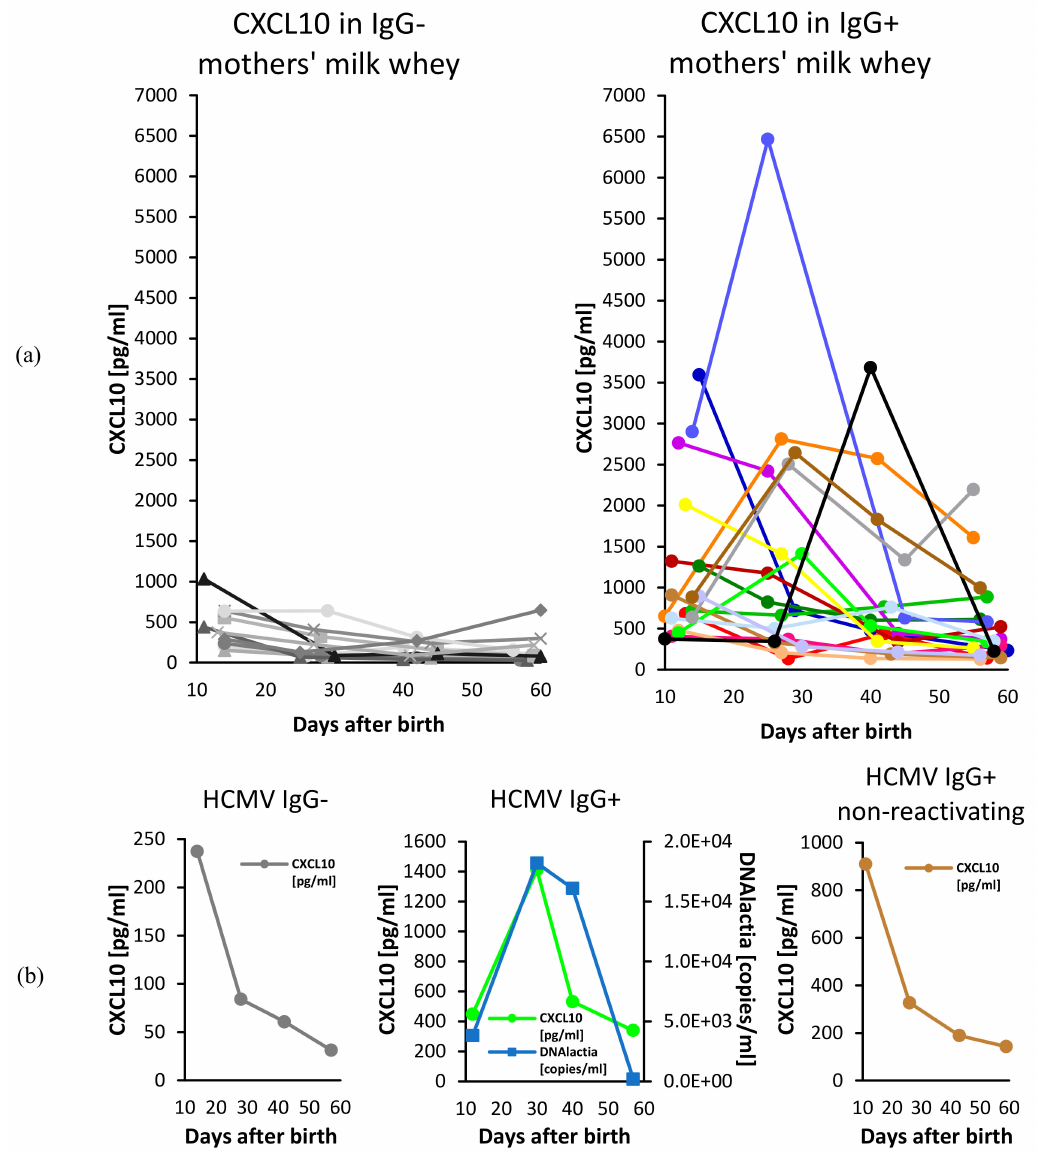
Figure 4. Longitudinal CXCL10 levels [pg / ml] in ( a ) 18 IgG-seropositive (right) and ten IgG-seronegative (left) mothers‘ milk wheys and ( b ) three individual courses of one seronegative, one seropositive, and one seropositive mother without HCMV shedding in breast milk. The three CXCL10 courses in ( b ) and Figure 1 can be attributed to individual courses in ( a ) by identical color